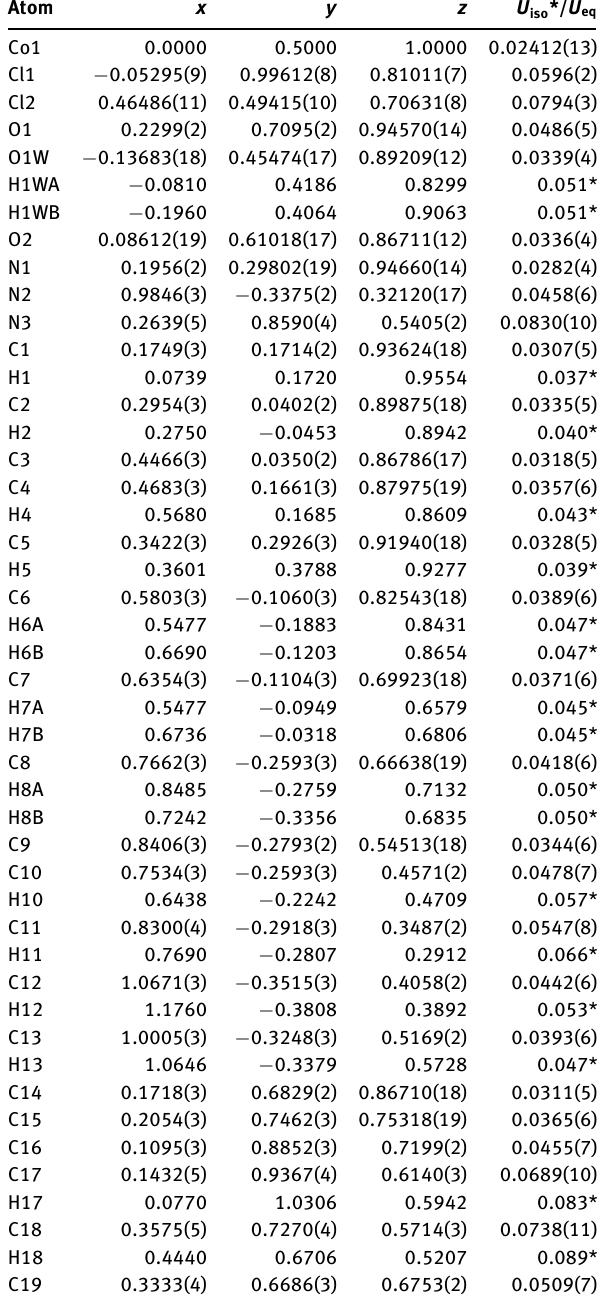
Table 2: Fractional atomic coordinates and isotropic or equivalent isotropic displacement parameters (Å 2